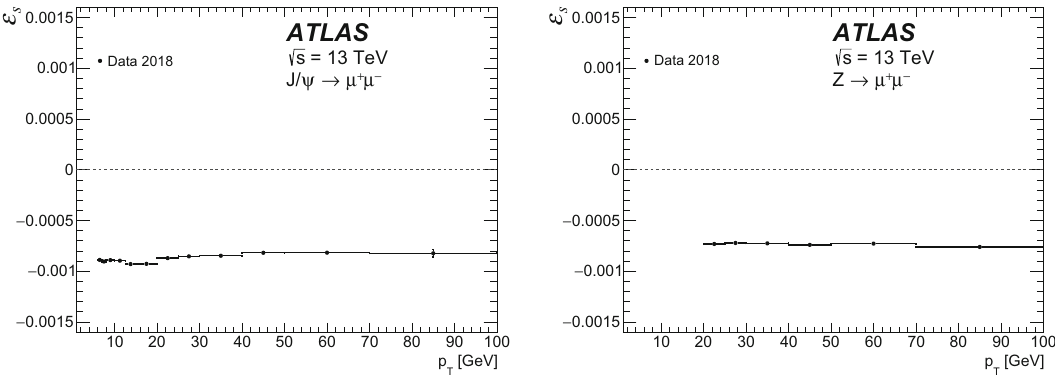
Fig. 23 The measured momentum scale bias ε s as a function of track p T . Error bars represent the statistical uncertainty. Left: J /ψ → μ + μ − decays; right: Z → μ + μ − decays ε = ε ε = ε − ε s z , and r z is the difference between the radial r (cid:5) and longitudinal components of the momentum scale.